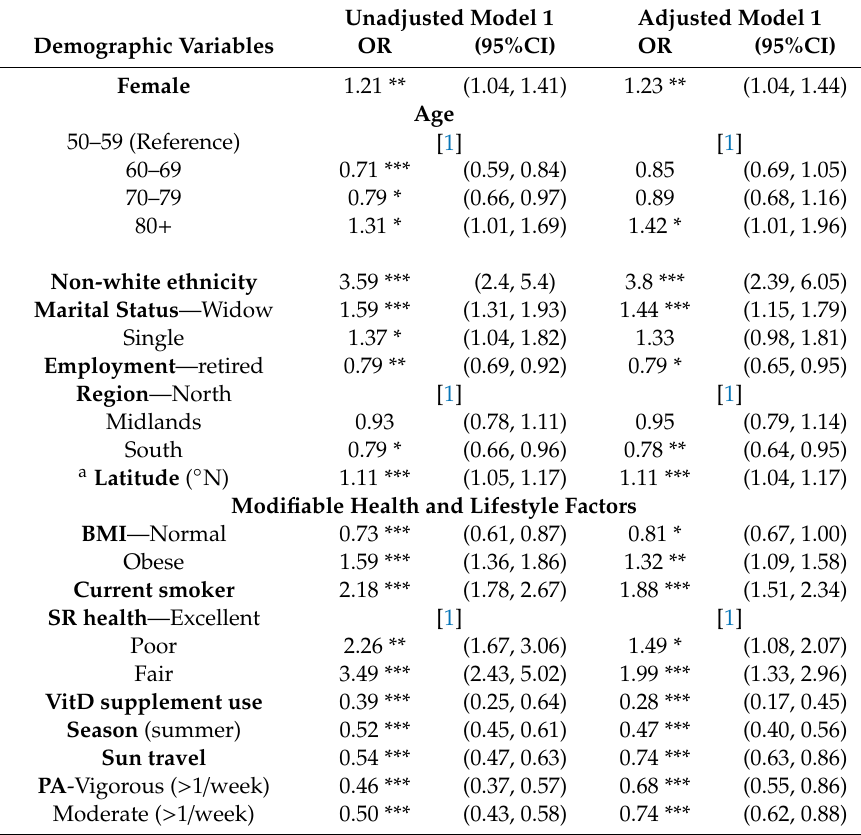
Table 3. Weighted logistic regression for predictors of vitamin D deficiency ( < 30 nmol / L) in ELSA study participants ( n =